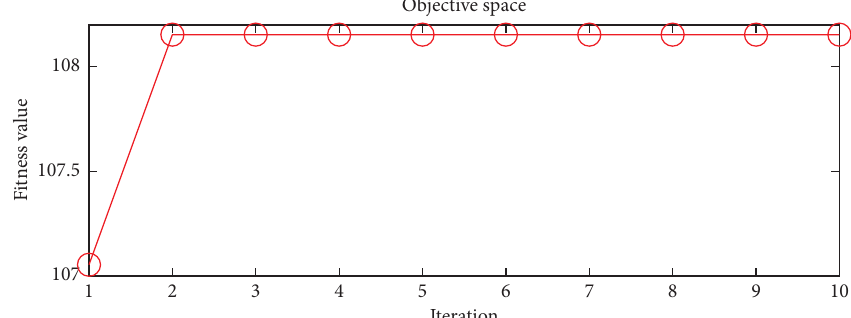
Figure 26: Experimental signals of case 2: PSO convergence curve based on IPAVMD.